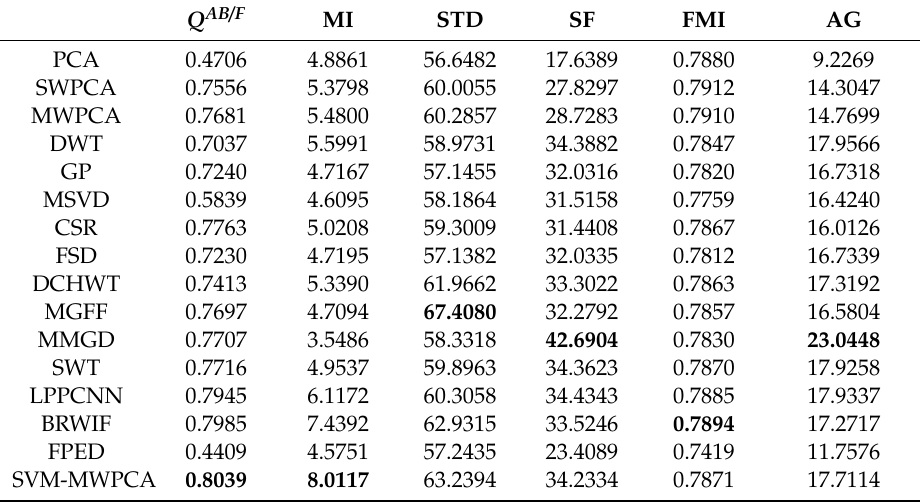
Table 1. Evaluation indexes of the fused images in source image pair